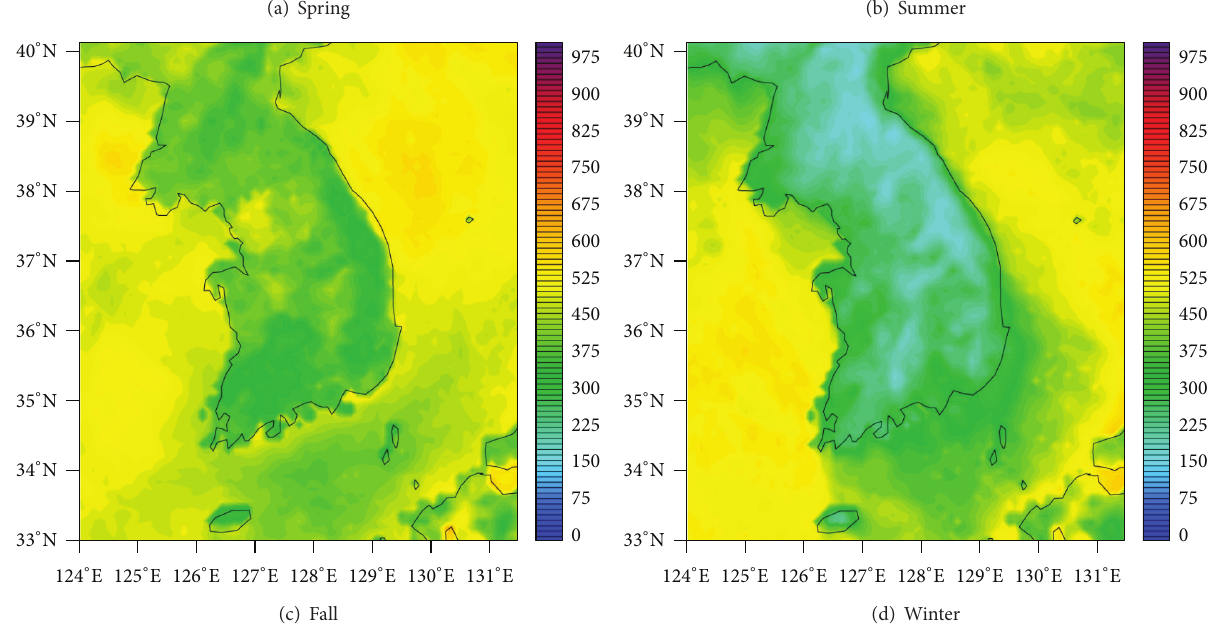
Figure 9: Same as Figure 8, except for DMMH’s standard